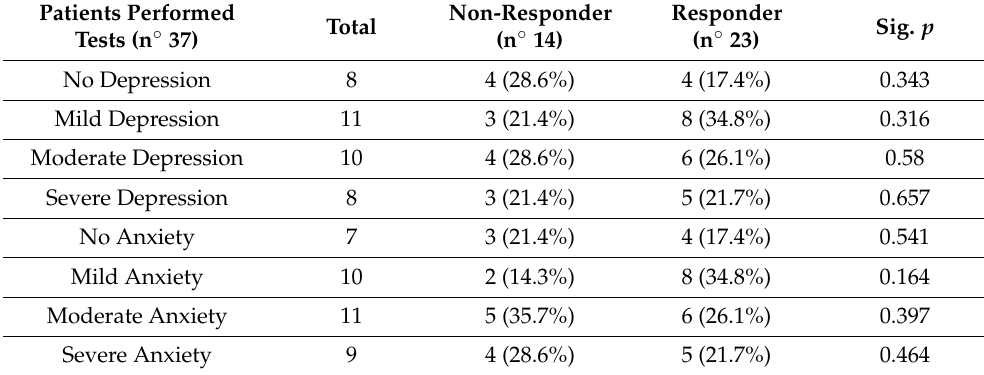
Table 2. Differences in psychological outcomes between responders and non-responders. Patients